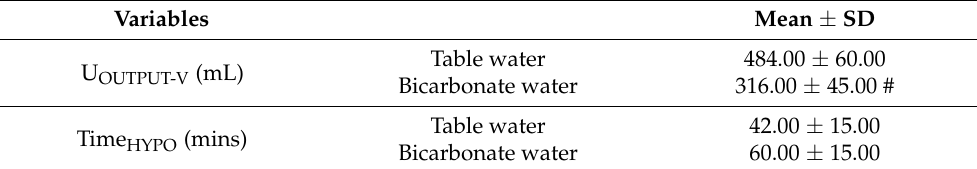
Table 6. The differences in selected variables of hydration kinetics after table water and bicarbonate- rich water ingestion.